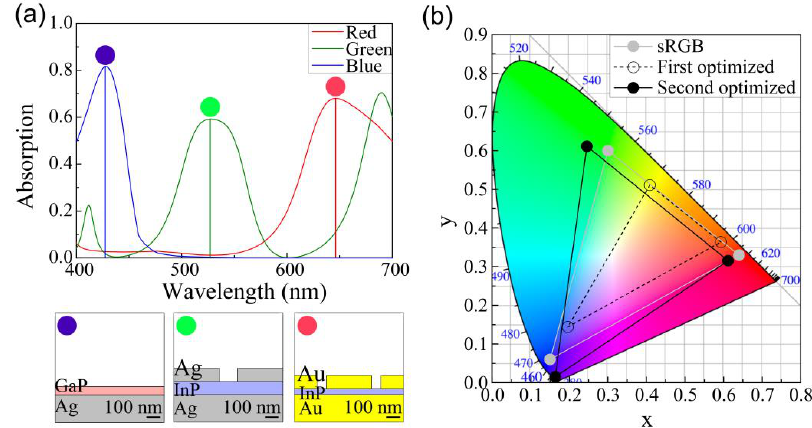
Figure 5. ( a ) Absorption spectrums and ( b ) color coordinates in the CIE space for the second optimized structures. The red, green, and blue colors are detected by each structure depicted in Figure 4a,c,e, respectively. The colored circles indicate the detected colors corresponding to the absorption spectrum. First (open circle, dashed line) and second (solid circle, solid line) optimized structures of ( b ) represent the structures in Figure 3 and Figure 4, respectively.